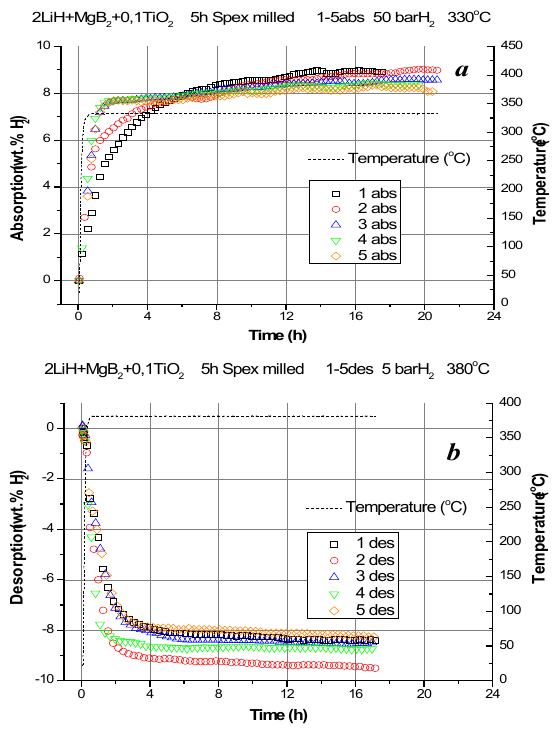
Figure 6. Hydrogen sorption for LiH–MgB molar ratio during 5 cycles. Absorption was performed at 330ºC and 50 bar of hydrogen pressure (a); desorption was performed at 380ºC and 5 bar H